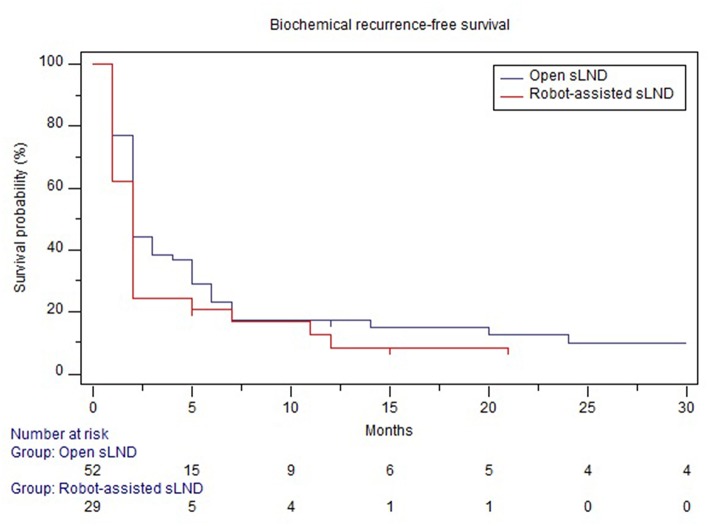
Comparison of biochemical recurrence-free survival between open and robotic sLND. Censored patients are marked with small vertical lines.